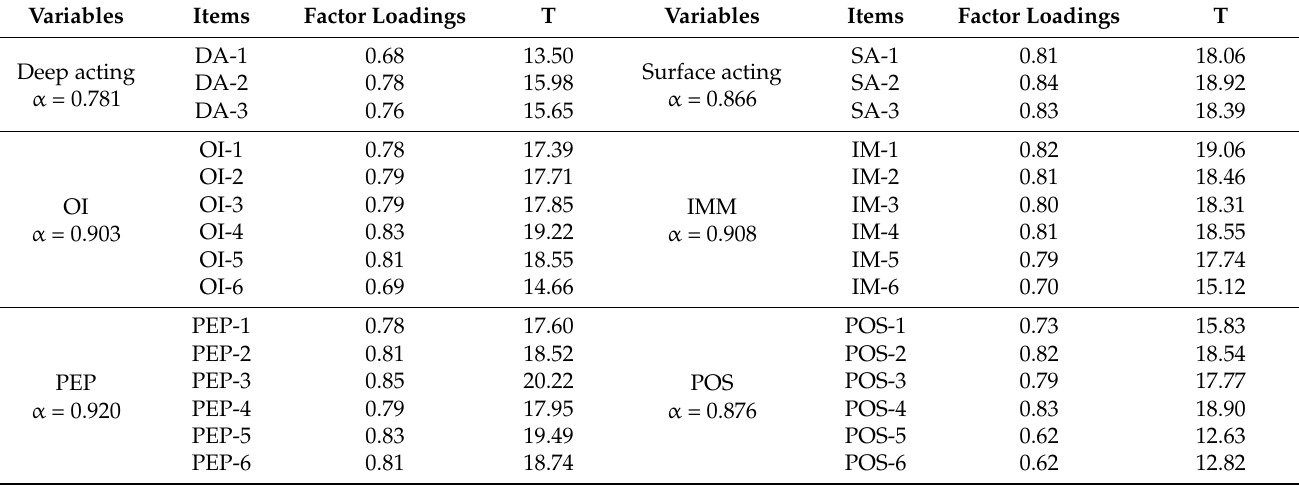
Table 1. CFA and Reliability.